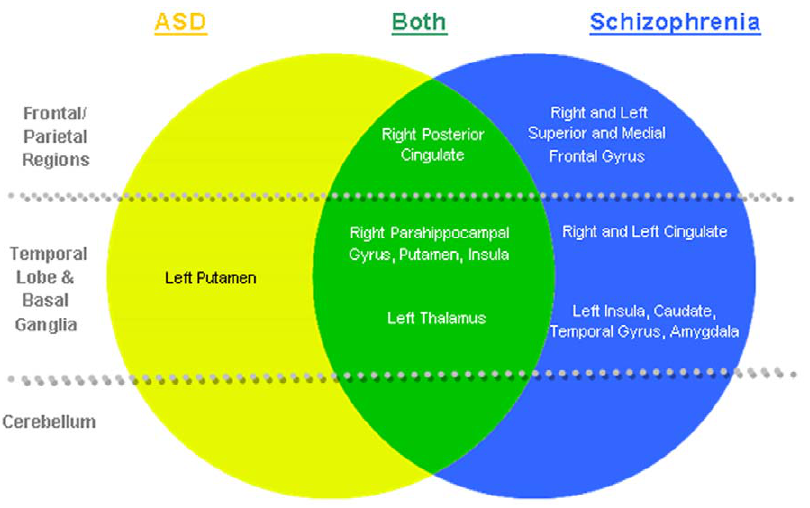
Figure 3. Distinct and overlapping regions of grey matter deficits found in ASD and Schizophrenia.